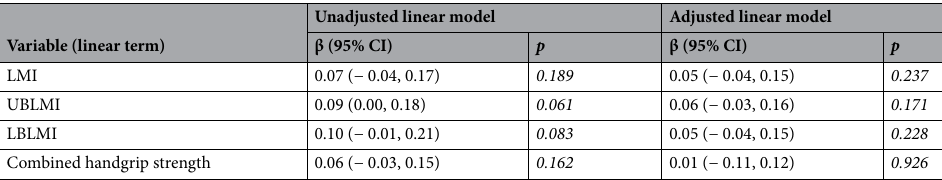
Table 2. Standardised linear effect of total testosterone on lean index (LMI), upper body lean mass index (UBLMI), lower body lean mass index (LBLMI) or combined handgrip strength in 18–40-year-old females (n =